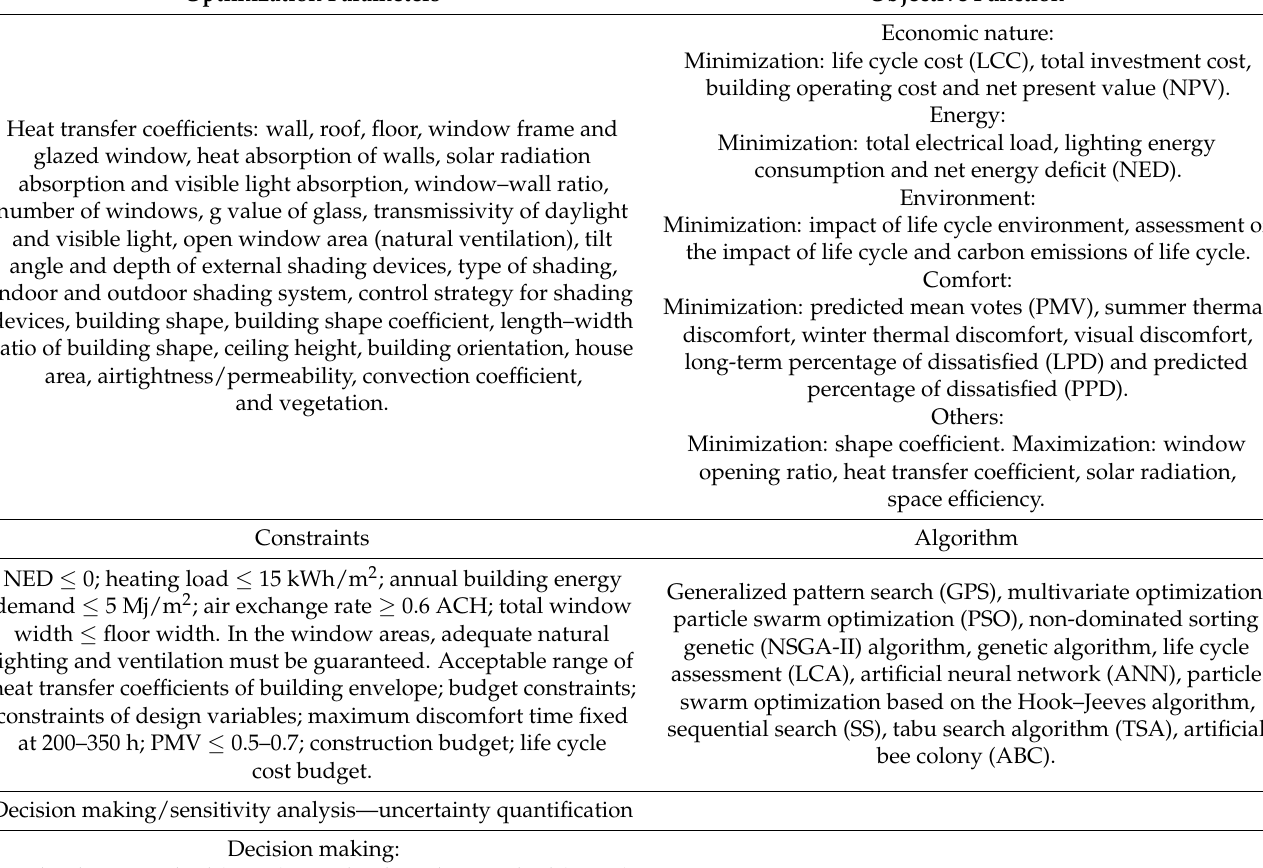
Table 4. Optimization parameters and their associated settings of previous